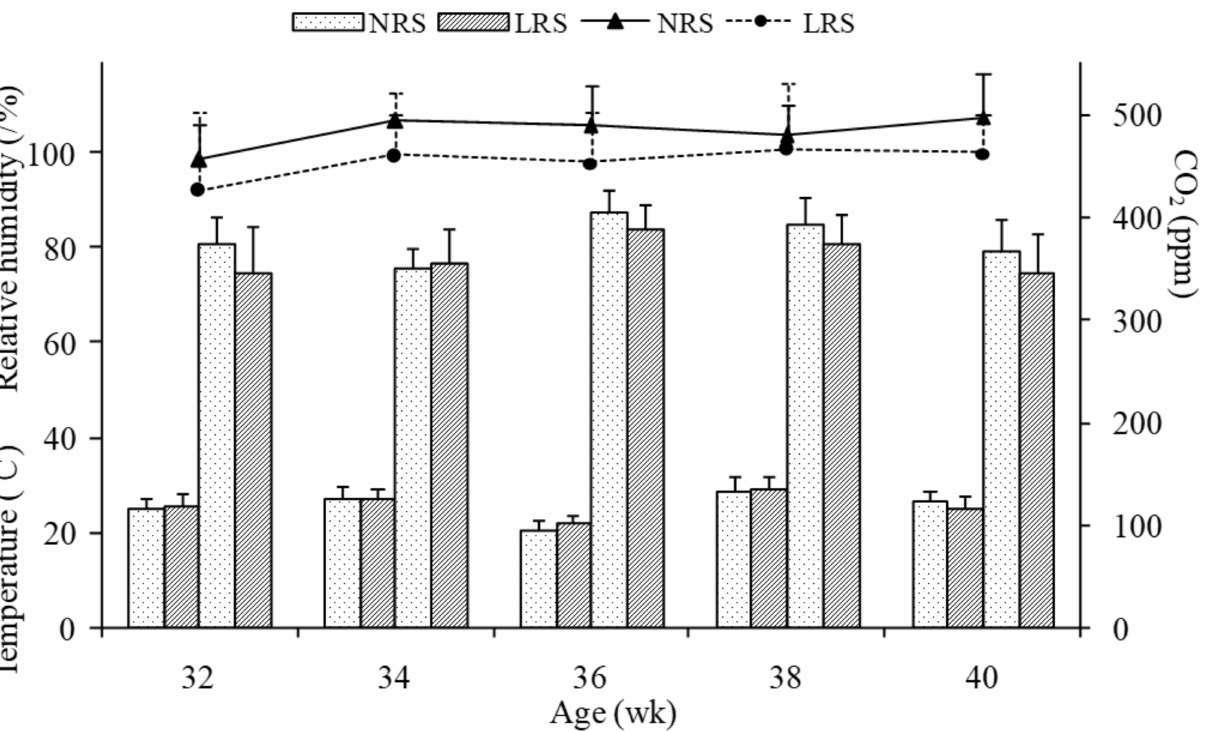
Figure 1. Temperature, relative humidity and CO 2 concentration in the two housing system houses. Dotted lines represent the floor-litter housing system (LRS), and solid lines represent the plastic-net housing system (NRS). Lines connected above the bars indicate the standard deviation. wk,